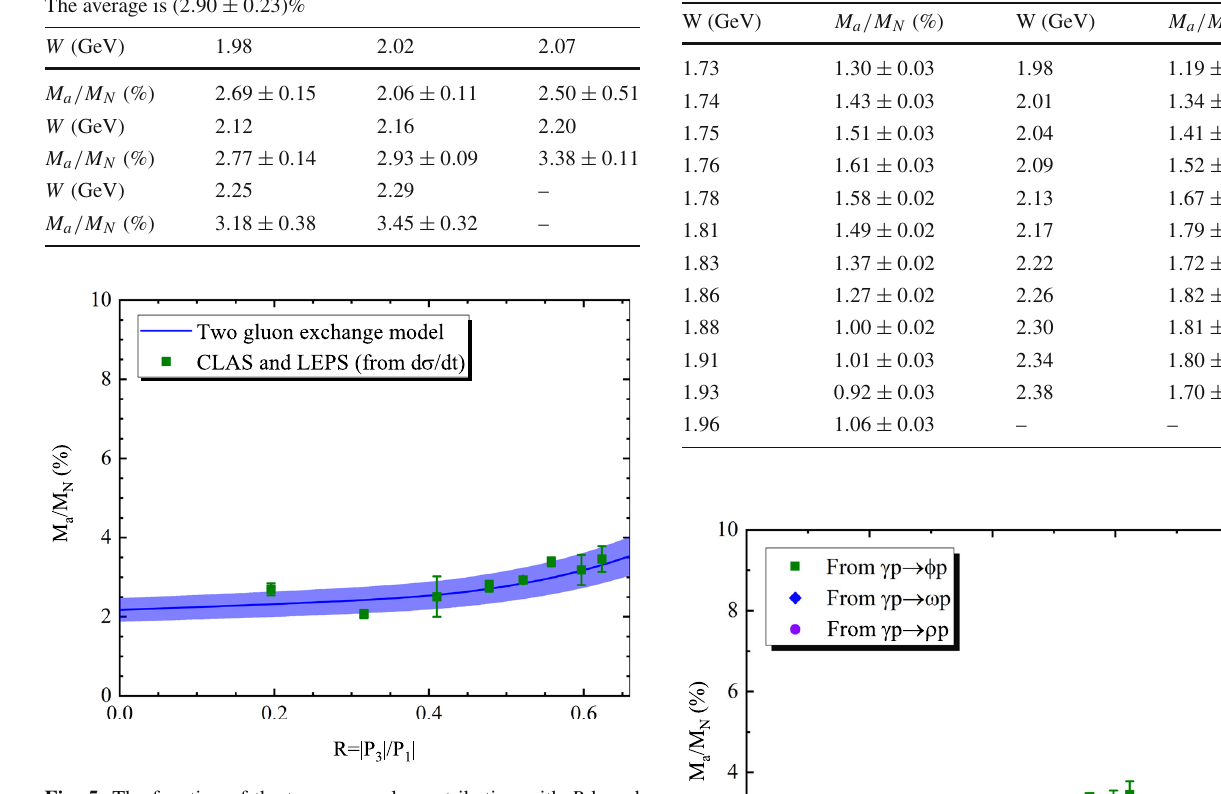
of φ predicted by the two thr